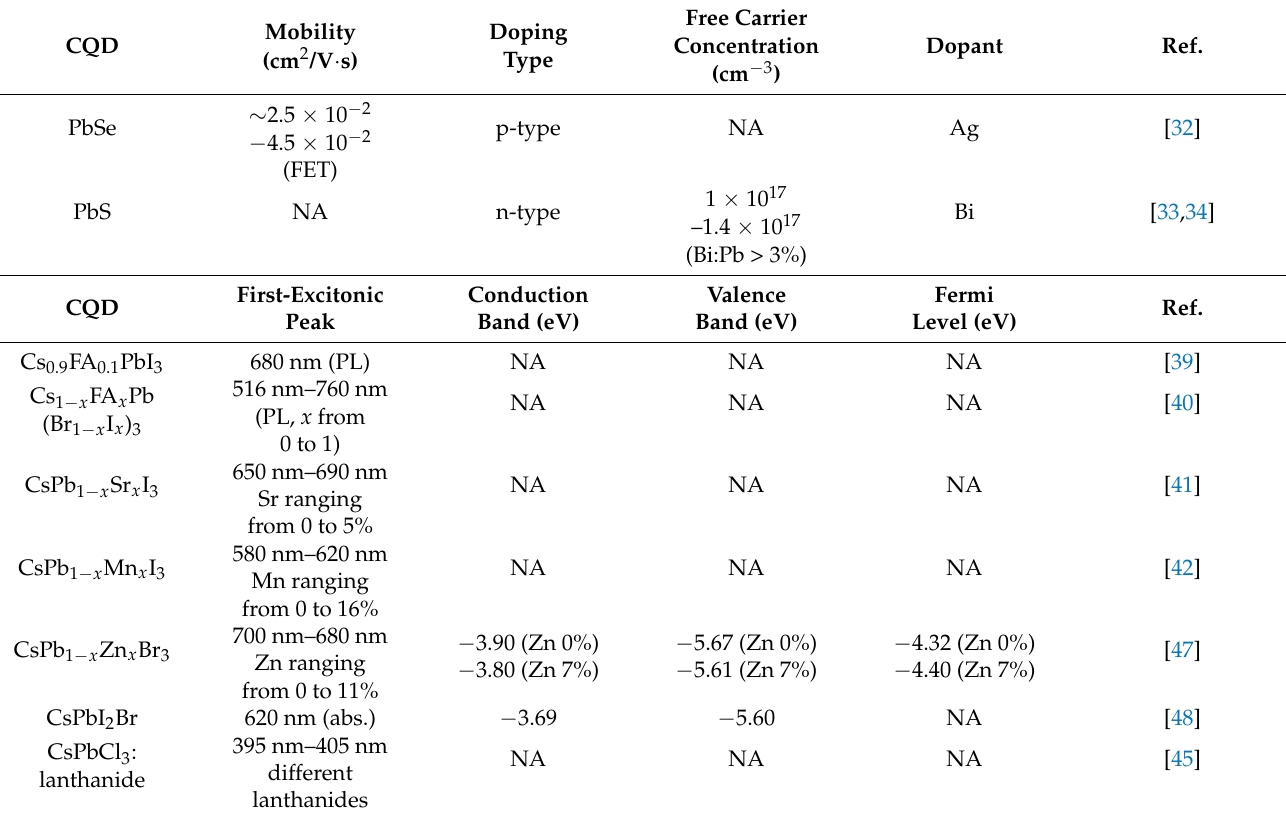
Table 2. Significant examples of the doping effect by